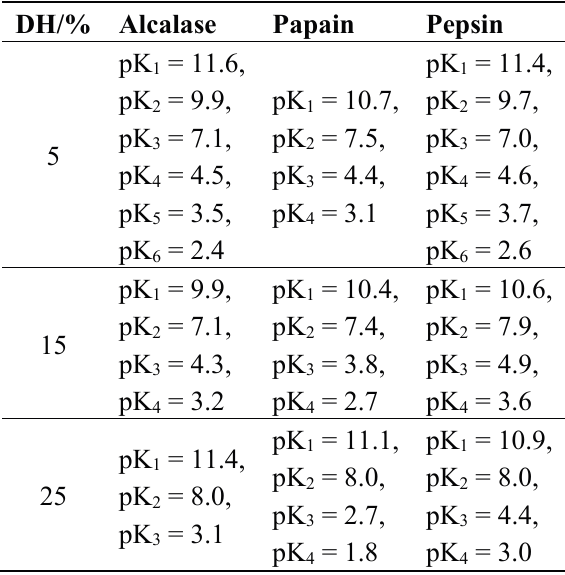
Table 3. Dissociation constants of TCPs at 25 °C, I = 0.1 M